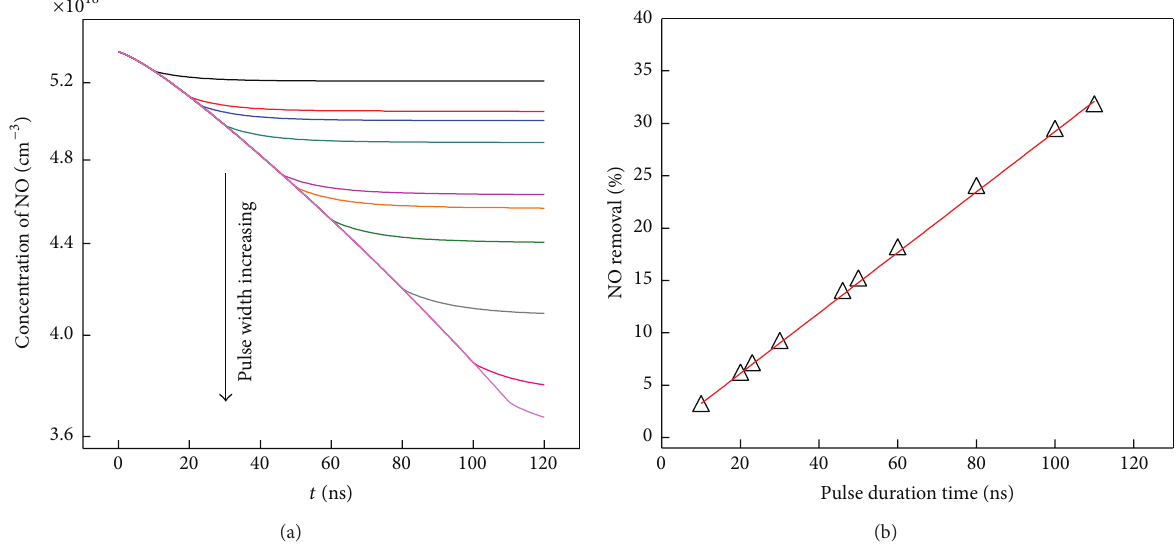
Figure 10: (a) NO concentration and (b) NO removal percentage achieved by adjusting pulse discharge duration